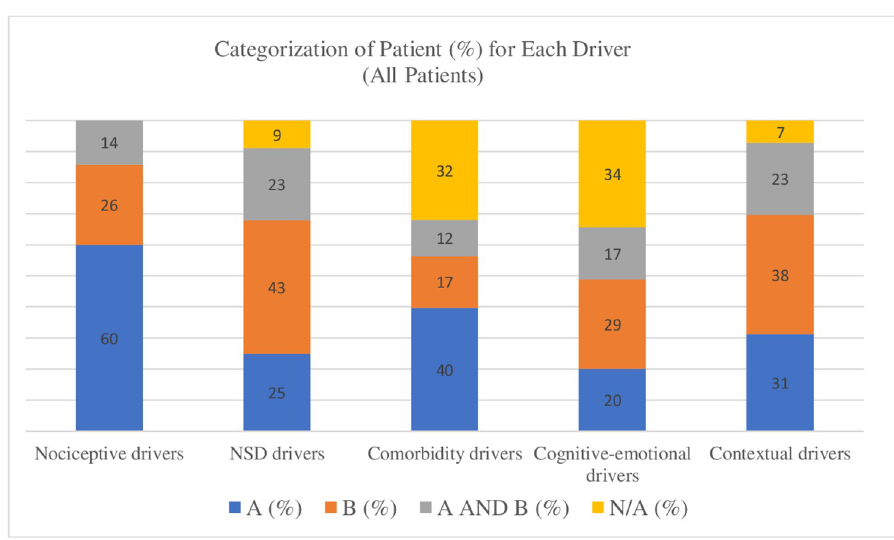
Fig 2. Percentage of patients categorized in the different categories of each domain of the